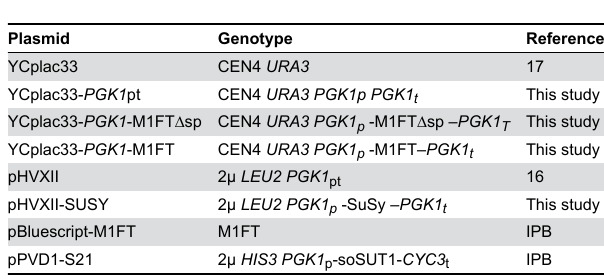
Table 3. Description of the plasmids used in this study.